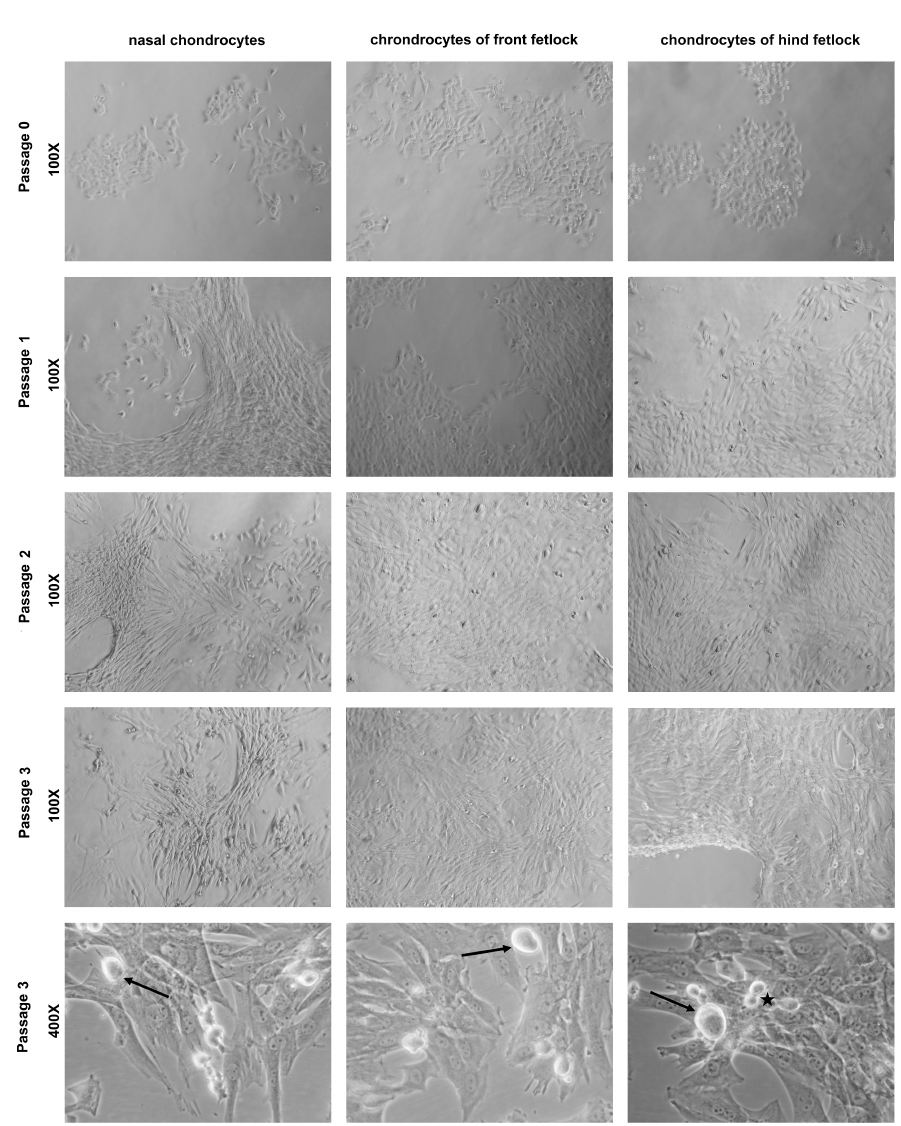
Figure A1. Representative images of cultured equine chondrocytes of the three different locations in P0, P1, P2 and P3 (100 × and 400 × magnification, respectively). In P1, all cell cultures contained polygonal and spindle-shaped cells. Nasal cell cultures showed a higher proportion of spindle-shaped chondrocytes than articular cultures. In P2, most of the nasal chondrocytes were spindle-shaped, whereas the number of polygonal and spindle-shaped articular chondrocytes was approximately equal. In P3, nearly all cells were spindle-shaped regardless of their site of origin. Bottom row: enlarged and irregularly shaped chondrocytes (arrows) were observed next to normally shaped and sized chondrocytes undergoing mitosis